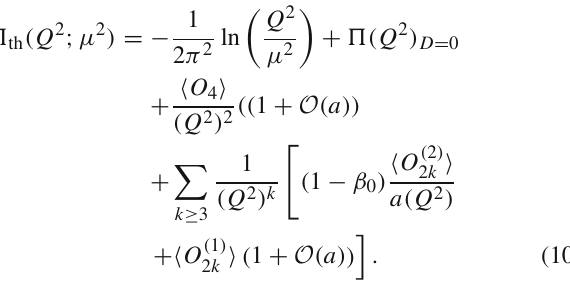
Fig. 1 The closed integration path C 1 + C 2 for The radius of the circle C 2 is | Q 2 | = σ max ( ≡ σ m ) ( ≤ m 2 τ ). In the sectors of the path C 1 we have ε → +